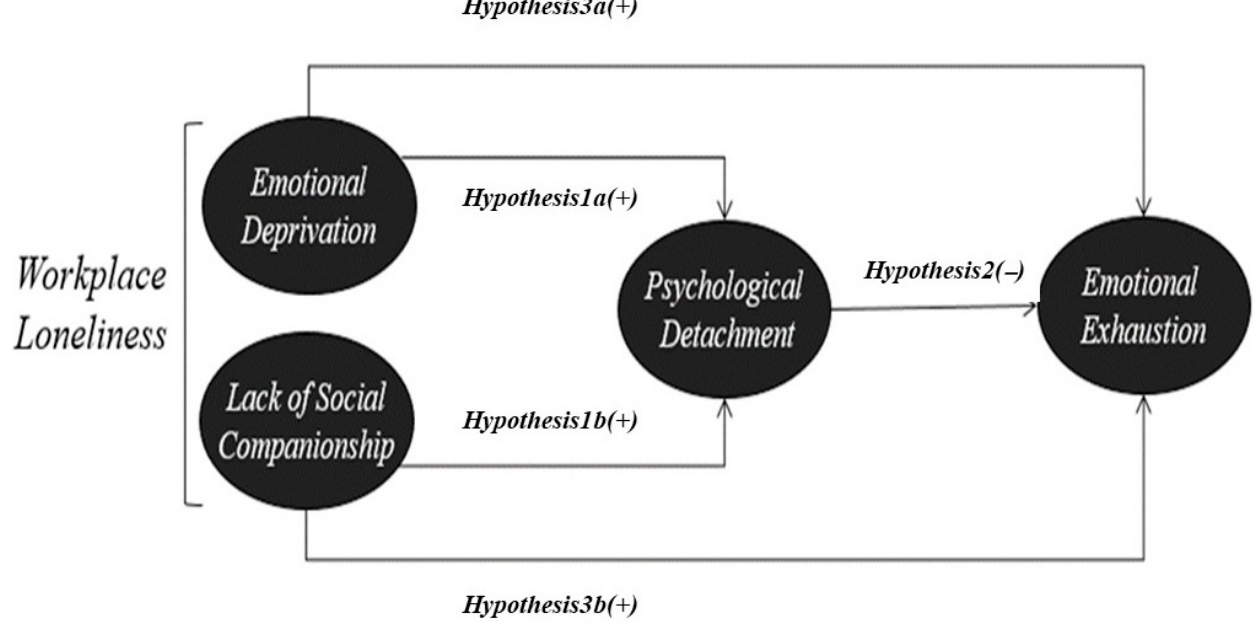
Figure 1. The proposed model of workplace loneliness, psychological detachment, and emotional exhaustion.